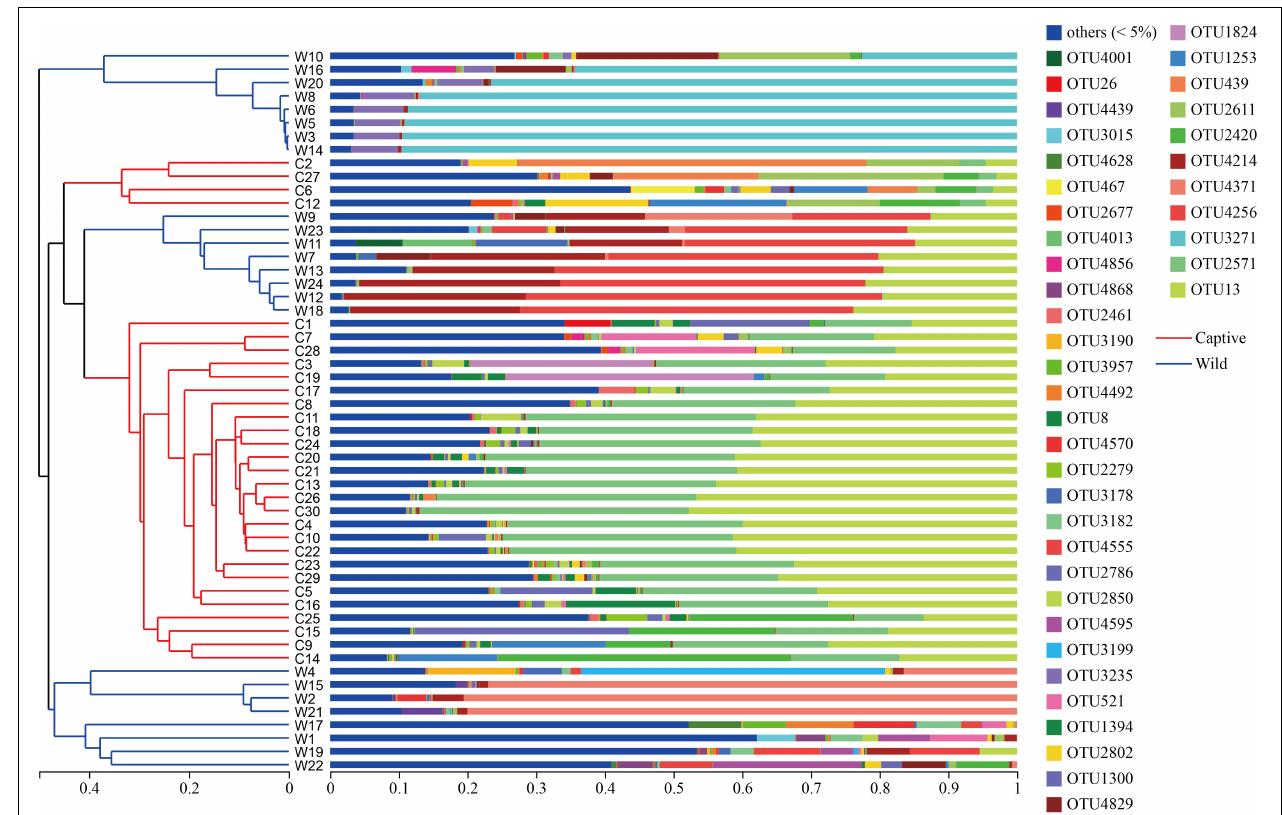
FIGURE 2 | Hierarchical cluster analysis based on Bray–Curtis distance algorithm at the OTU